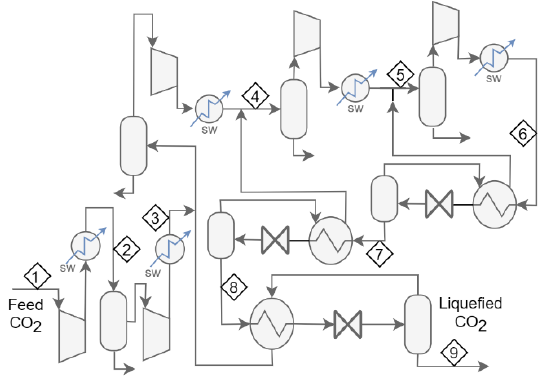
Figure 3. Flow scheme for Case 6a. In Case 6b, each of the three letdown valves is replaced with an expander.